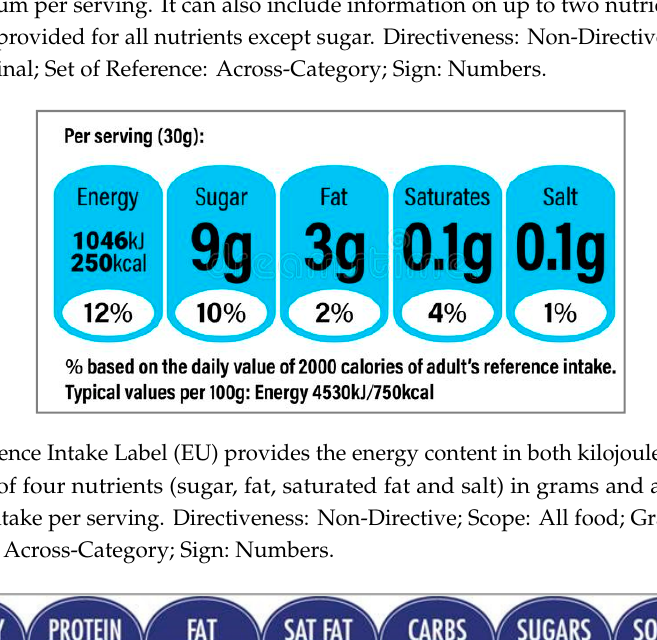
sugars, and sodium per serving. It can also include information on up to two nutrients to encourage.